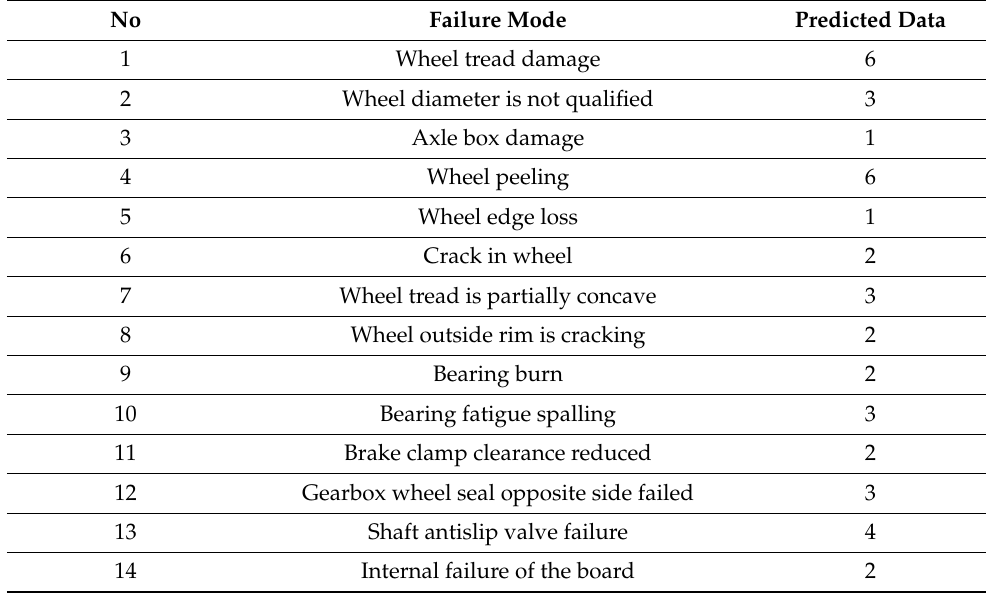
Table 2. Bogie wheelset system fault prediction